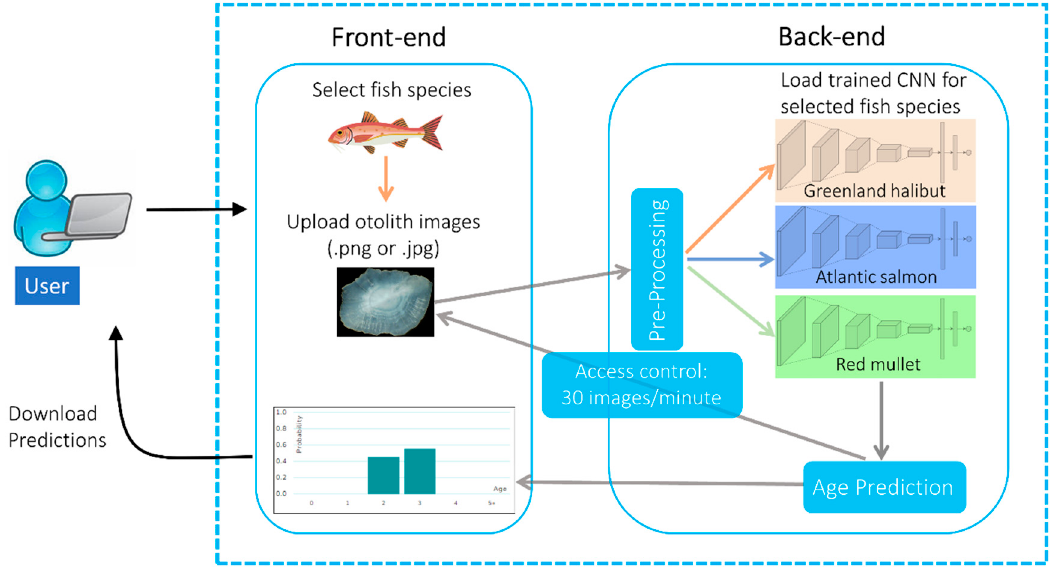
Figure 3. The architecture of the DeepOtolith